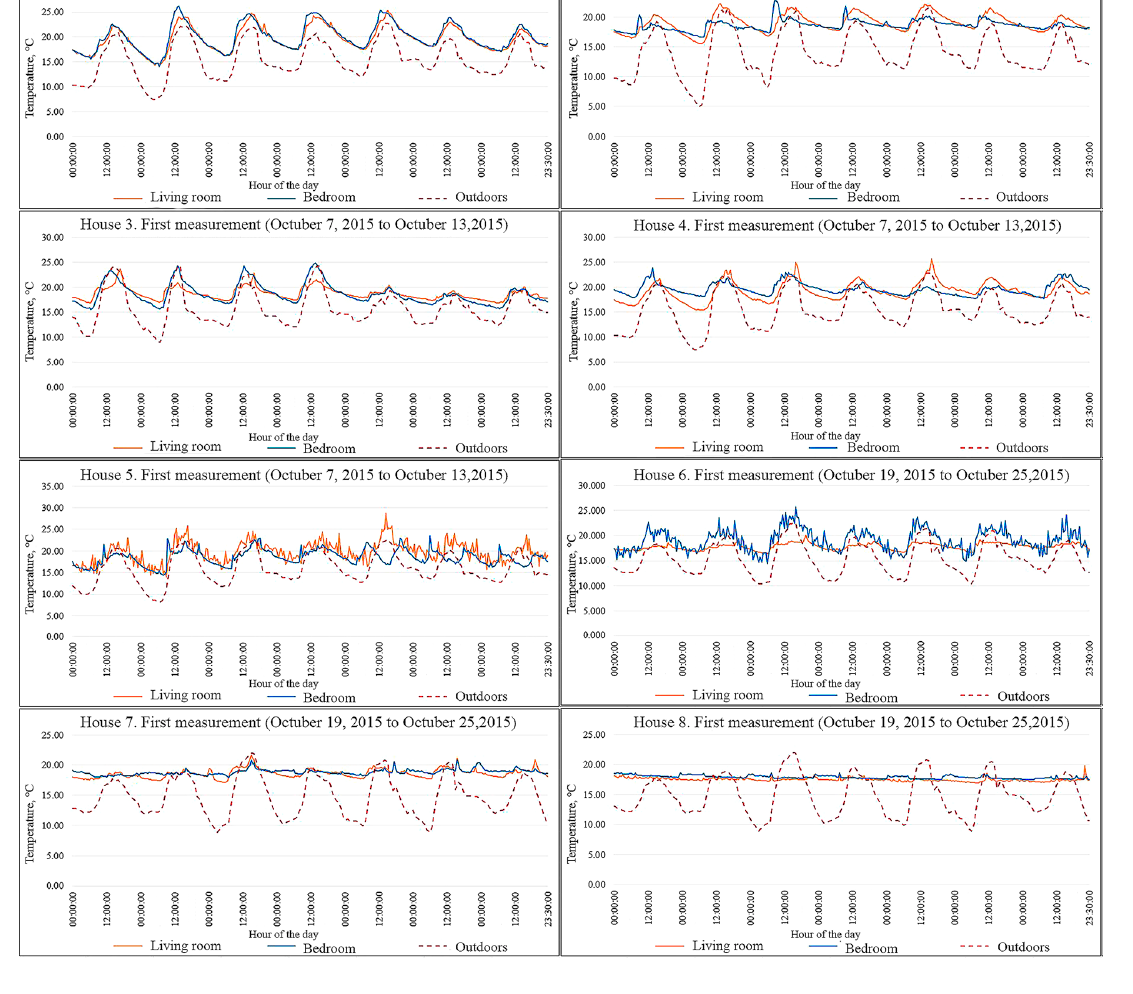
Figure 4. Operative and external temperature measurements (includes all studied cases) during the first monitoring of the cold period in October. Data from: Environmental monitoring.